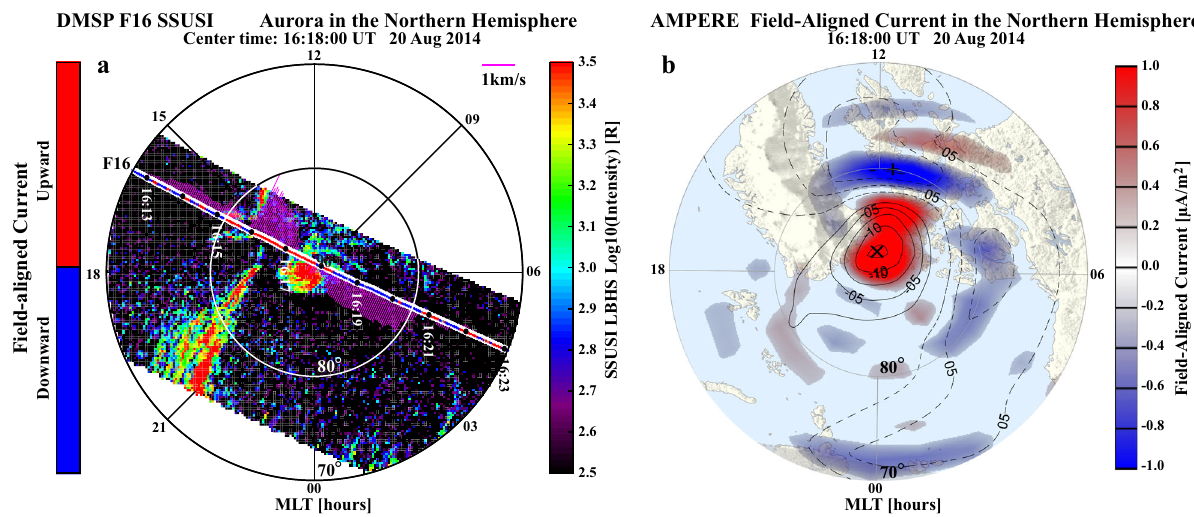
Fig. 2 An example of aurora and FACs observations in the polar region of the Northern Hemisphere. a Aurora in the Lyman – Birge – Hop fi eld short-band (LBHS) band (wavelength of 140 – 150 nm), the measured cross-track horizontal ion fl ows shown in mauve drift vectors perpendicular to the orbit, and the sign of the FACs shown in red and blue color along the satellite track. The aurora is observed by the SSUSI instrument on board the DMSP F16 satellite, the ion fl ow is measured by the special sensor for ions, electrons, and scintillation (SSIES) and the FAC is calculated from the magnetic fi eld measurement of special sensor microwave (SSM) instrument. These instruments are all on board the DMSP F16 satellite. b The distribution map of the FACs and potential of AMPERE magnetic perturbation data products derived from the Iridium satellites